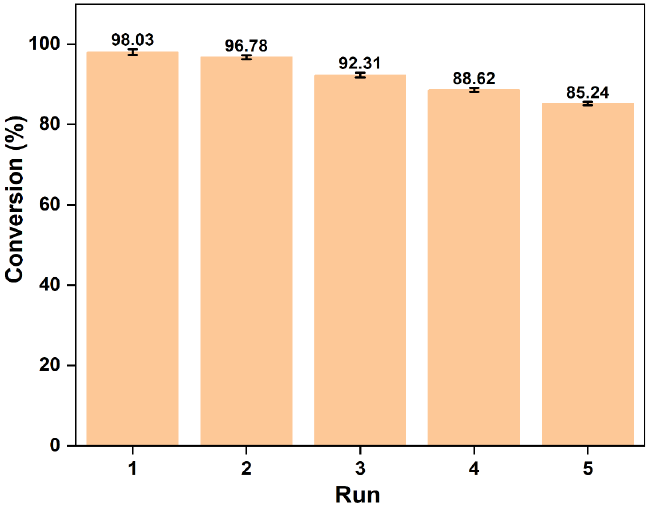
Figure 14. Reusability of CaO−ZrO 2 catalyst in the transesterification of soybean oil over 5 cycles.